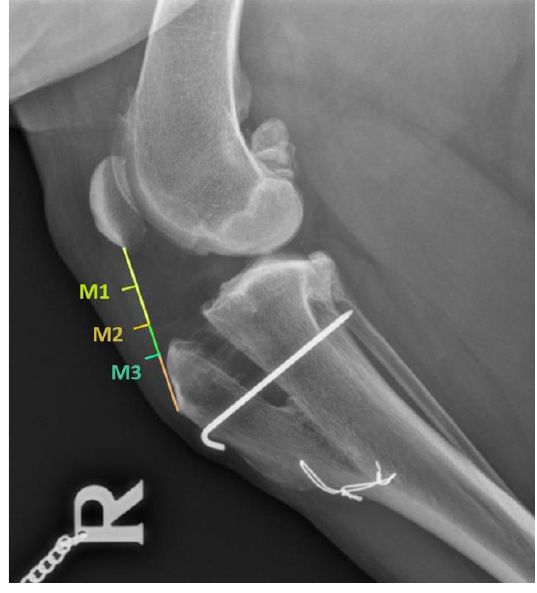
Figure 1. Patellar ligament measurements.